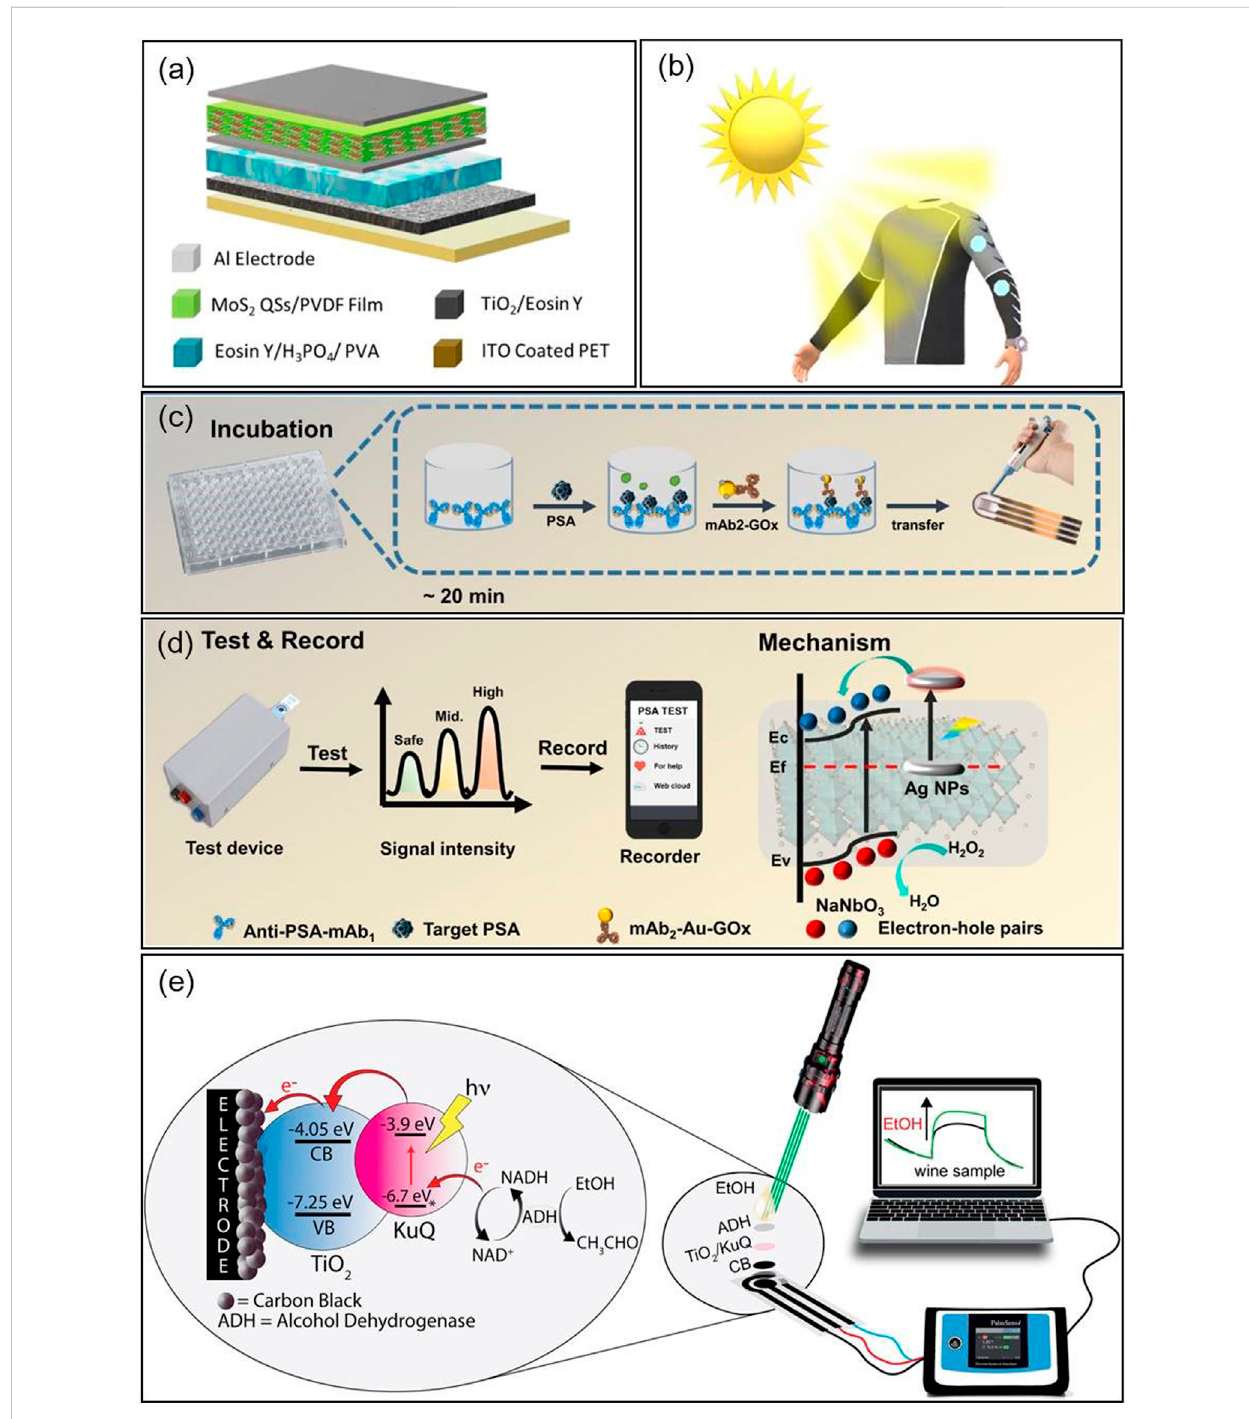
FIGURE 5 (A) Schematic diagram of the PSCPC device. (B) Conceptional representation of the PSCPC absorbing natural sunlight for powering smart gadgets (Nardekar et al., 2022). (C) Schematic illustration of the incubation process of target PSA in a microtiter plate. (D) Schematic illustration of the PEC recording platform for 3D printed microdevices and the photoelectron transfer of the Ag/NaNbO 3 composites. (Xu et al., 2022b). (E) Schematic illustration of the photoelectrochemical sensing system and the experimental set-up for detection of ethanol (Mazzaracchio et al.,